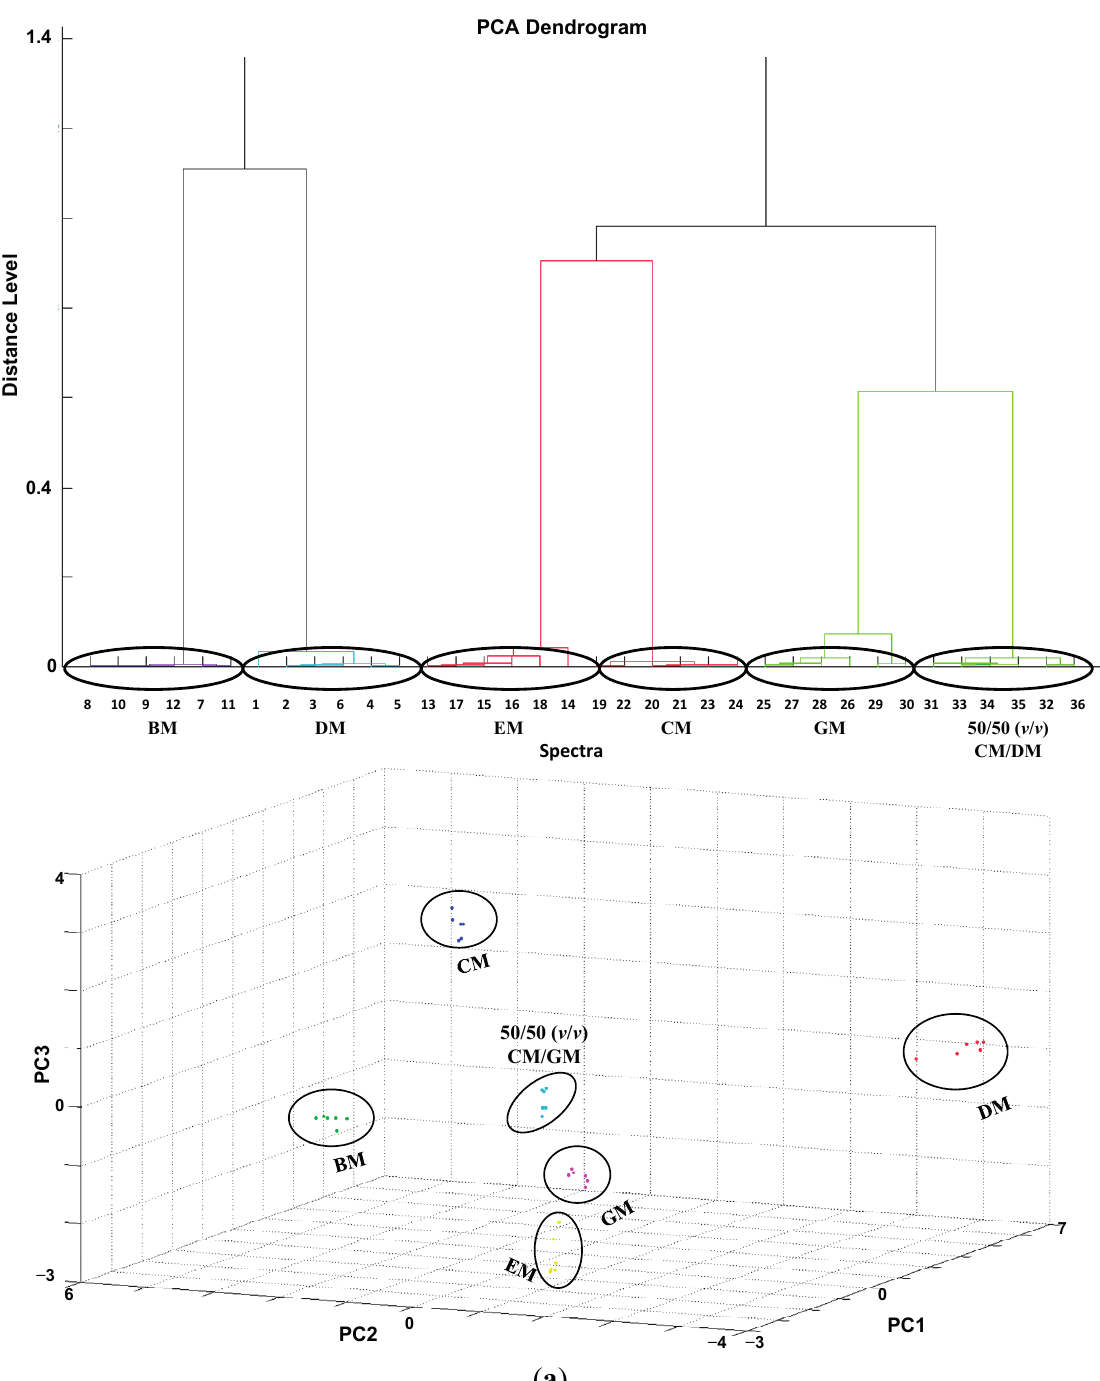
Figure 7. Hierarchical clustering dendrograms and PCA 3D scatter plots of the first three principle components for the four mixtures (50%, 10%, 2%, and 0.2%) of the simulated adulteration of GM by CM ( Panels a – d ). All milk adulteration grouped inside the correct clade and